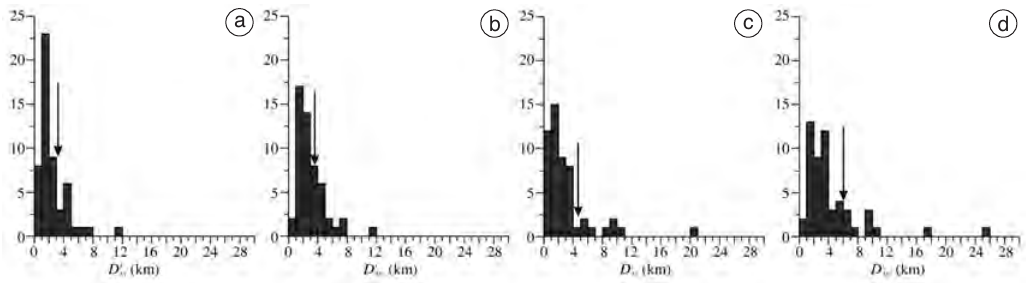
Fig. 5a-d. Histograms of and (see equations in Section 3) of the events of the swarm from the inte- grated network LS (panels a and b) and the land-based network L (panels c and d). Arrows indicate the average values of D